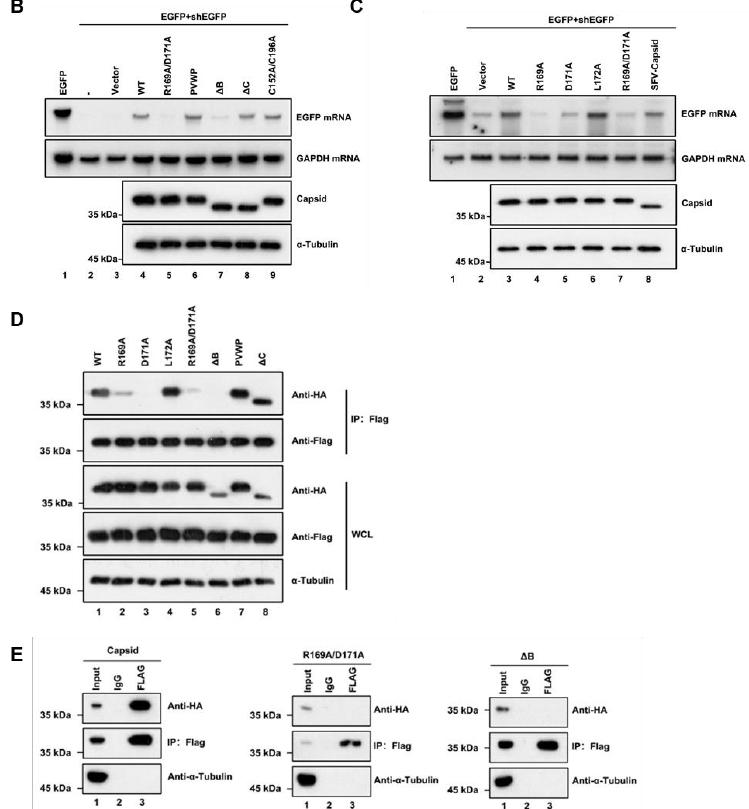
Figure 4. The residues R169 and D171 of the RuV capsid are critical for RNAi suppression activity. ( A ) Diagram of the RuV capsid dimer structure. The β-strands A–E were shown as arrows and the helix H was shown as a cylinder. ( B , C ) HEK293T cells were co-transfected with plasmids encoding EGFP (100 ng) and shEGFP (300 ng), together with a plasmid encoding RuV capsid WT , single-point or double-point mutations, or deletion mutants (1 µ g for each). Empty vector (Vec) and SFV capsid were used as a mock control and a positive control, respectively. Cellular lysate and total RNAs were harvested and analyzed by Western and Northern blotting. ( D ) HEK293T cells were co-transfected with a plasmid encoding Flag-tagged RuV capsid WT (1 µ g), together with a plasmid encoding HA-tagged RuV capsid single-point or double-point mutations or deletion mutant (1 µ g for each). At 48 hpt, cell lysate was used to perform co-IP with anti-Flag antibody. The complex was analyzed by Western blotting. ( E ) HEK293T cells were co-transfected with a plasmid encoding Flag-tagged and a plasmid encoding HA-tagged RuV capsid single-point or double-point mutations or deletion mutant (1 µ g for each). At 48 hpt, cellular lysate was used to perform co-IP with anti-Flag antibody. IP samples were harvested and analyzed by Western blotting. All the experiments have been independently repeated at least three times with reproducible results, and the representative results are